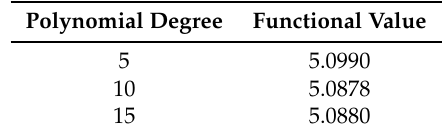
Table 1. J values for several polynomial degree